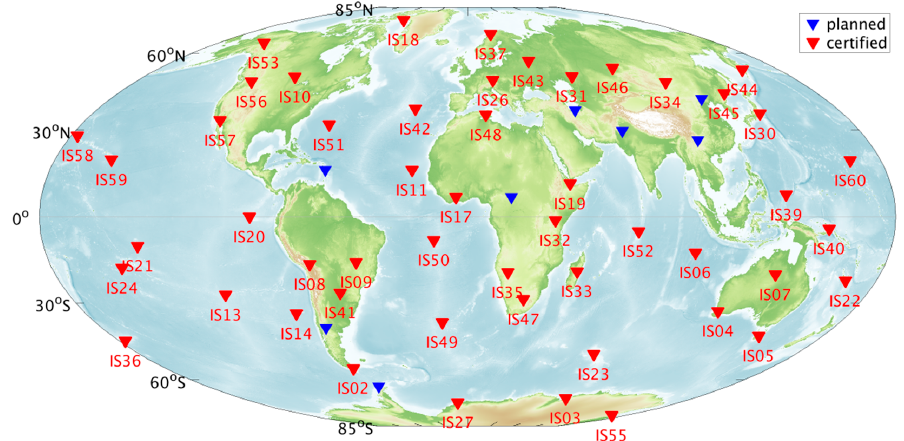
Figure 1. The International Monitoring System (IMS) infrasound network will consist of 60 stations distributed around the globe. As of June 2019, 51 stations have been certified. These recordings of a particular IMS infrasound station, IS17 in Côte d’Ivoire, were used by [16] for deriving GW parameters—more precisely, they argued that only trapped GWs cause traceable pressure fluctuations at the surface. Before that study, [13] reported on infrasound-based GW observations at the same station. They used the Progressive Multi-Channel Correlation (PMCC) method [17,18] for the automatic detection of such events. The back-azimuth of the detections showed a clear correlation with the seasonal movement of the Inter-Tropical Convergence Zone (ITCZ) relative to the station. For the calculation of GW parameters, such as horizontal and vertical wavenumber, the authors of [16] combined the PMCC detection parameters and meteorological data. This allowed estimating the vertical GW momentum flux at the top of the ducting layer, which was shown for a particular event detected at IS17.